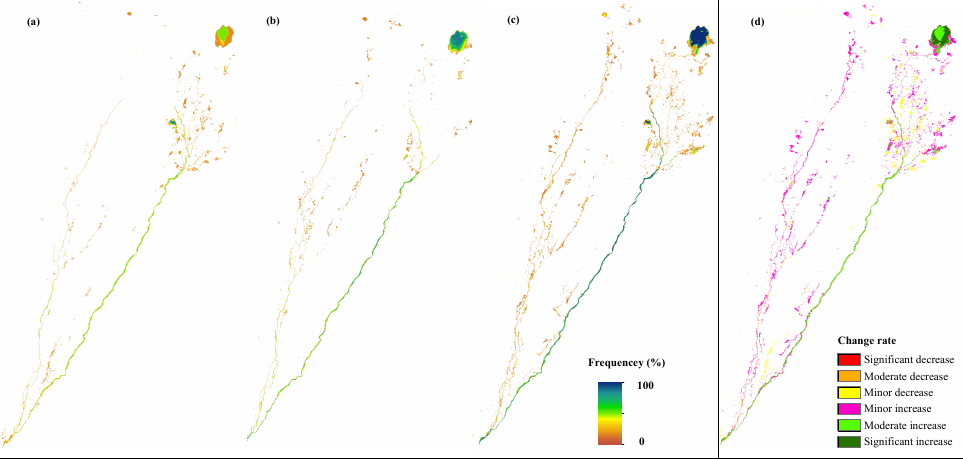
Figure 6. Frequency of inundation for (a) period 1 (1988–1998), (b) period 2 (2000–2007) and (c) period 3 (2008–2015); (d) the change rate between periods 1 and 3. Table 3. Pearson correlation coefficients indicating relationship between vegetation dynamics (spatial distribution and FVC) and variations in river flows. “–” means no significant correlation was detected while a and b denote that the detected correlation was significant at 0.05 and 0.01 levels,